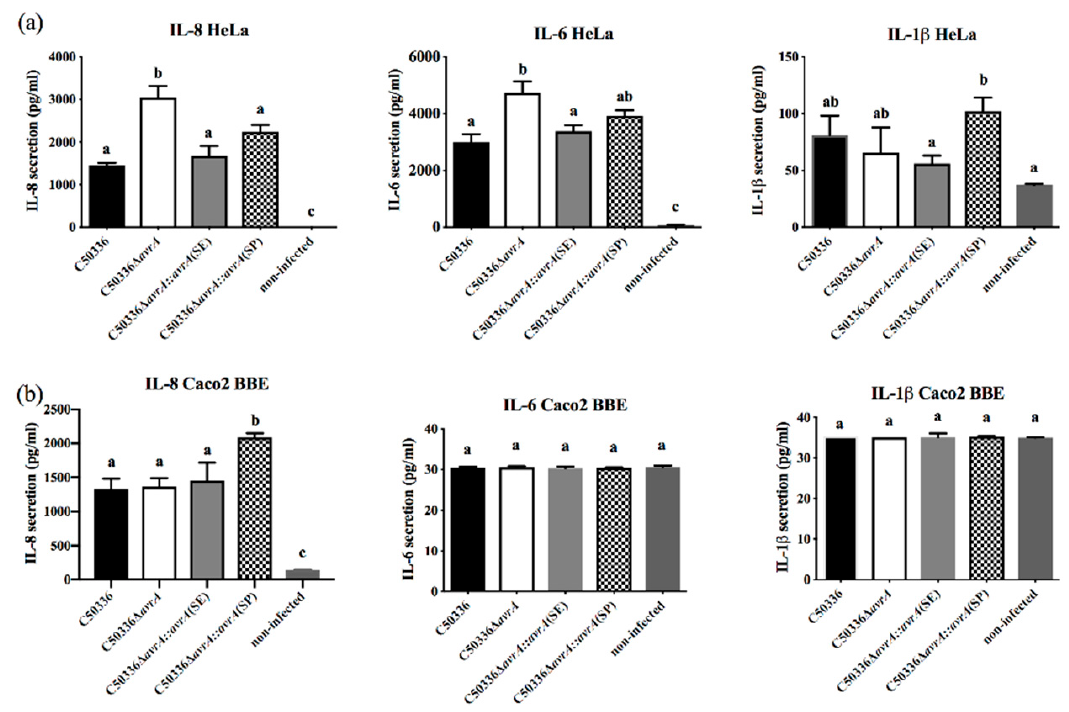
Figure 2. SP-AvrA exhibits weaker inhibition of proinflammatory cytokine secretion in HeLa cells infected by S . Enteritidis compared to SE-AvrA. The secreted protein levels of proinflammatory cytokines (IL-8, IL-6, and IL-1 β ) were measured in the supernatant of HeLa ( a ) or Caco2 BBE ( b ) cells infected with di ff erent S. Enteritidis strains after 7 h by using FACs according to the instruction of the Human Inflammatory Cytokines Kit (BD, Franklin Lakes Campus, NJ, USA). Data are expressed as the mean + SD. The di ff erent letters on the error bars indicate statistically significant di ff erences ( p < 0.05).